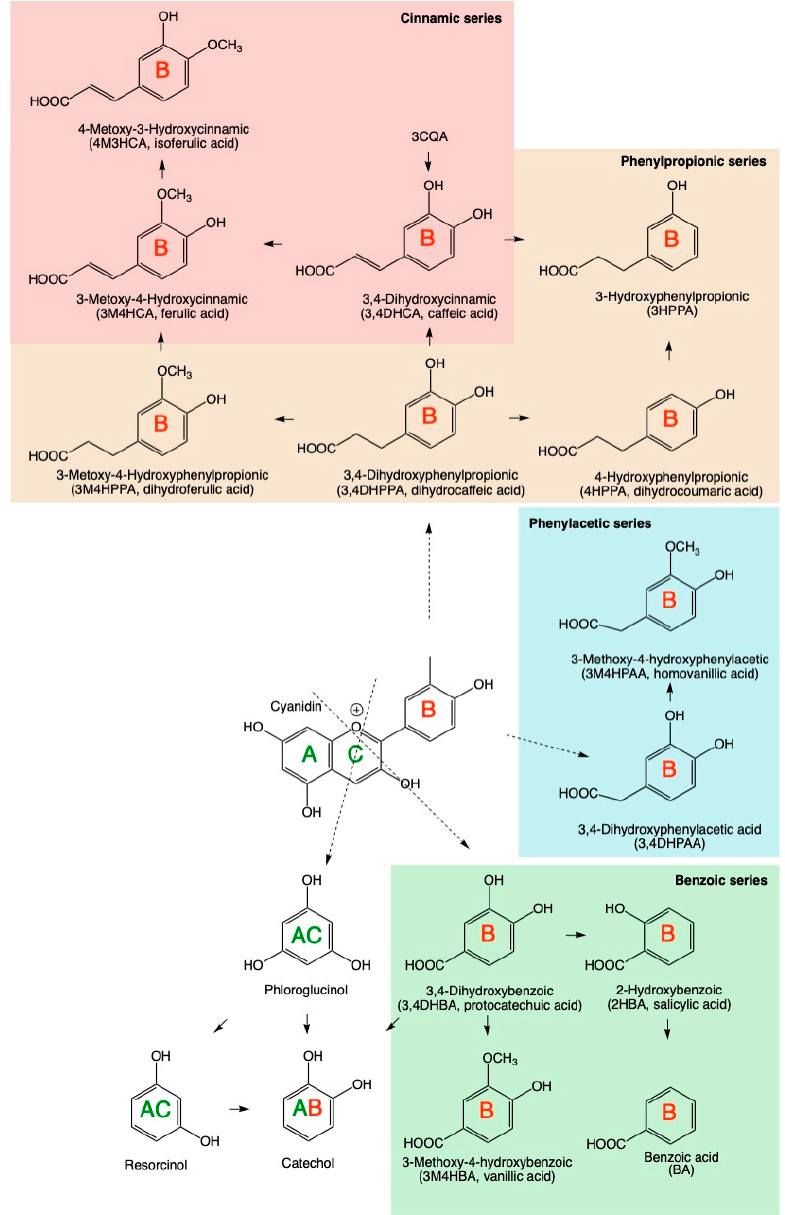
Figure 1. Schematic representation of a parental anthocyanin molecule and the major phenolic metabolites that are produced during the subsequent degradation and microbial fermentation of the parental anthocyanins. The nomenclature of phenolic acid metabolites is also listed in Table 1.